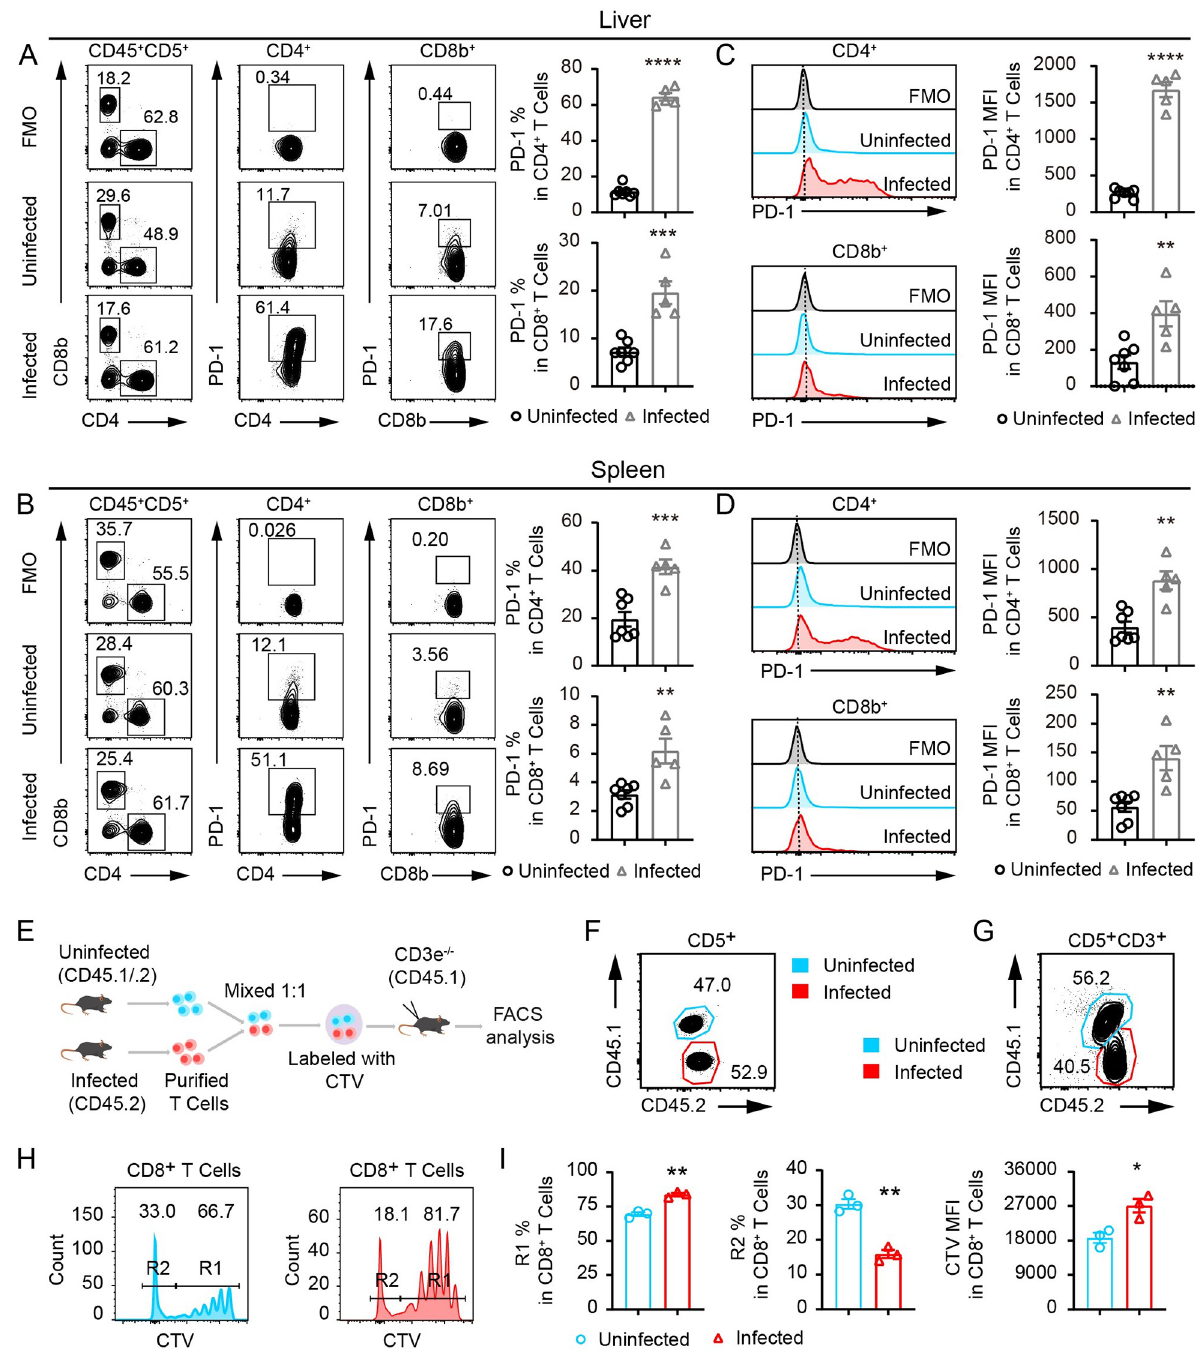
Fig 1. PD-1 expression induced in CD4 + and CD8 + T cells by S . japonicum infection. (A) Flow cytometric analyses of single cell suspension of the liver obtained by mechanic and enzymatic tissue dissociation with surface antigen labeling of CD45, CD5, CD4, CD8b and PD-1 from both uninfected control mice and mice infected with 30 S . japonicum cercariae for 8 weeks. Frequencies of PD-1 expressing cells were compared between two group of mice by gating the PD-1 positive compartment involving Fluorescence-minus-one or FMO control (Infected mice, n = 5; Uninfected mice, n = 7). (B) Flow cytometric analyses of single cell suspension of splenocytes obtained by mechanic and enzymatic tissue dissociation, and cells were labeled and analyzed in the same manner as shown in (A), (Infected mice, n = 5; Uninfected mice, n = 7). (C) Histogram comparison of PD-1 expression in liver CD4 + and CD8 + T cells and statistic comparisons of mean fluorescence intensity or MFI between the two group of mice analyzed in (A). (D) Histogram comparison of PD-1 expression in splenic CD4 + and CD8 + T cells and statistic comparisons of MFI between the two group of mice analyzed in (B). (E) Schematic presentation of adoptive transfer of T cells from S . japonicum infected and uninfected mice into CD3e − / − T cell